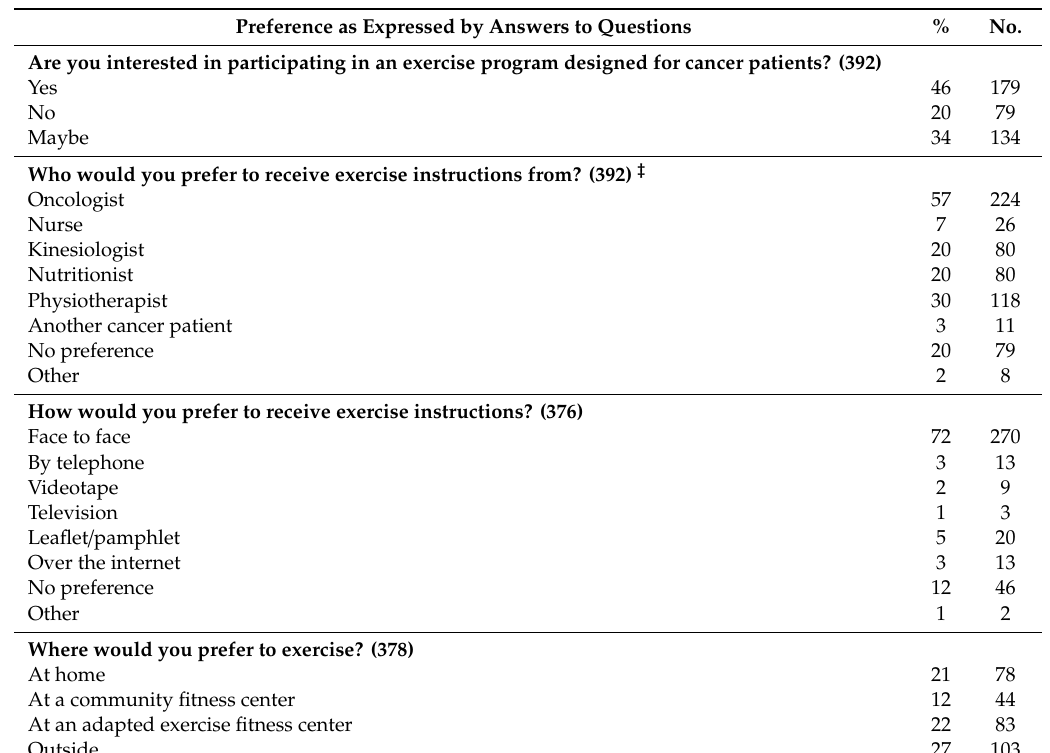
Table 3. Exercise preferences in cancer patients †